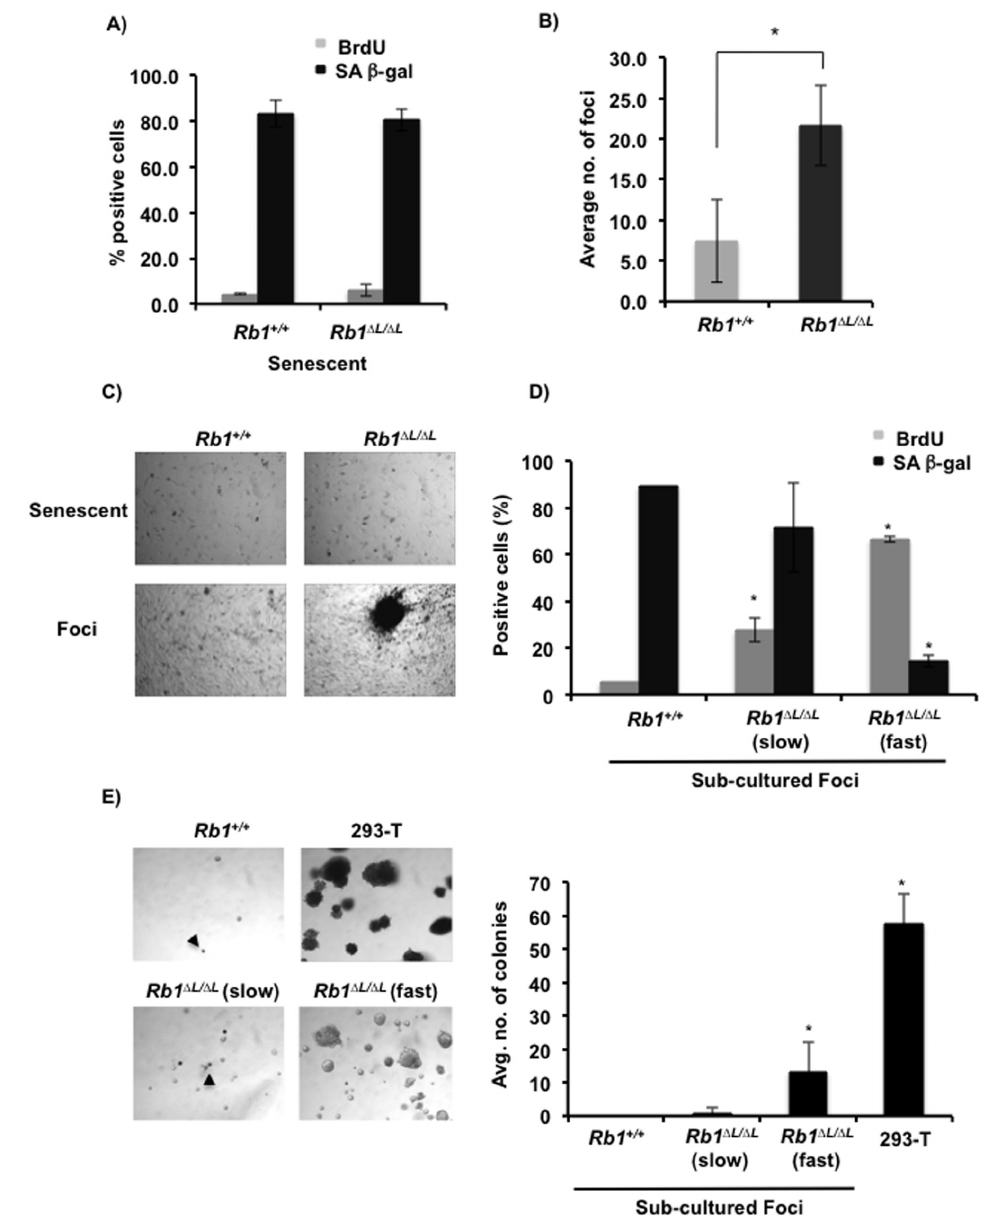
Figure 1. Escape from HrasV12 induced senescence and transformation in Rb1 ∆L/∆L MEFs. Asynchronously growing wild type and Rb1 ∆L/∆L MEFs are induced to senesce by retroviral mediated expression of oncogenic HrasV12. After 3 days of selection, cells were plated in medium and cultured for at least 10 days. All cells were pulse labeled with BrdU for 4 hours. ( A ) The percentage of BrdU and SA β-gal positive cells in senescent Rb1 +/+ and Rb1 ∆L/∆L cultures were determined. ( B ) Quantitation of foci from senescent Rb1 +/+ and Rb1 ∆L/∆L cultures. The average number of foci formed 3 weeks post selection were compared between genotypes. The mean number of foci was compared between genotypes using a t-test (* p<0.0004). ( C ) Phase contrast microscopy images of wild type and Rb1 ∆L/∆L cells either senescent (10 days post-selection) or foci (3 weeks post-selection). ( D ) The percentage of BrdU and SA β-gal positive cells in sub-cultured foci from senescent Rb1 +/+ and Rb1 ∆L/∆L cells was determined. Rb1 ∆L/∆L clones were grouped into slow growing (slow) or fast growing (fast) based on their proliferative capacity as determined by BrdU incorporation and SA β- gal staining. Mean values were compared with wild type controls using a t-test (* p<0.05). ( E ) Sub-cultured foci were also subjected to culture in soft agar to determine their capacity for anchorage independent growth. 293-T cells were used as a positive control. Quantitation after 2 weeks of culturing in soft agar is shown on the right. The average number of colonies/field was determined from 10 random fields and mean colony values were compared with wild type using a t-test. (* p<0.05). doi: 10.1371/journal.pone.0072236.g001 PLOS ONE |